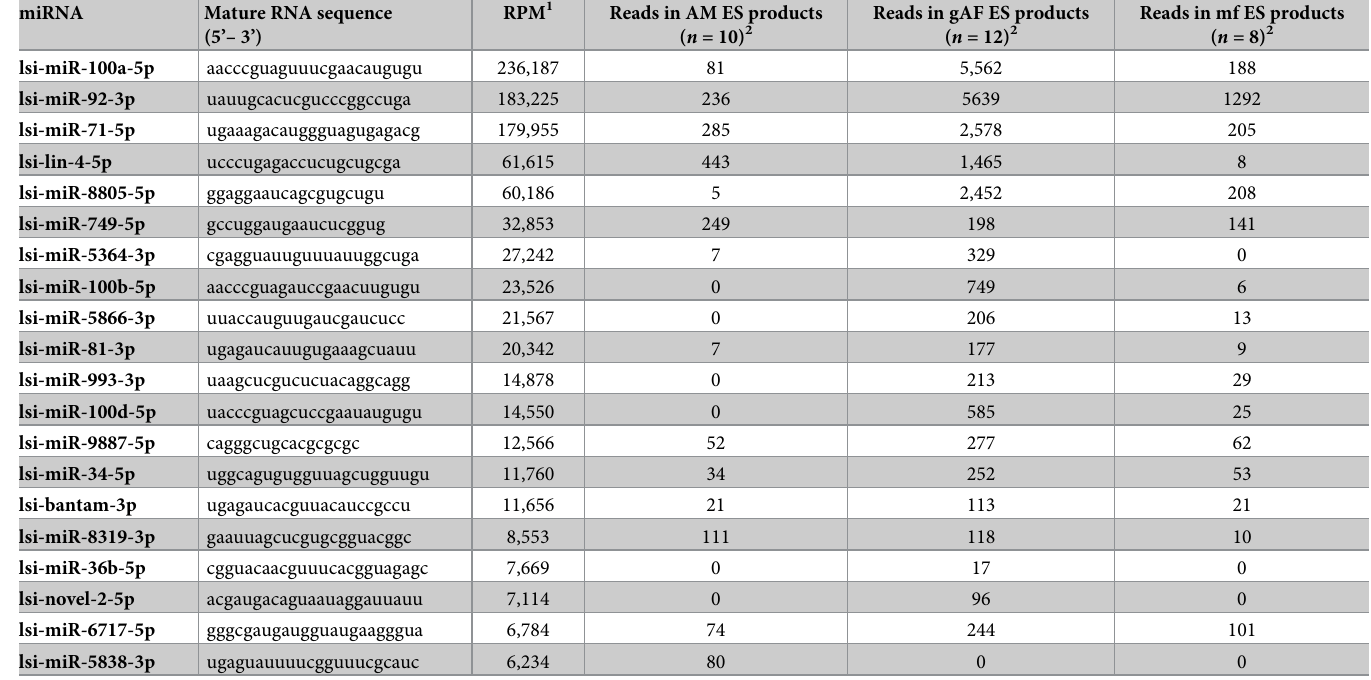
1 RPM = Reads per million L . sigmodontis miRNA reads in all the sequencing libraries combined. 2 The median of the sequencing read counts is reported for AM, gAF and